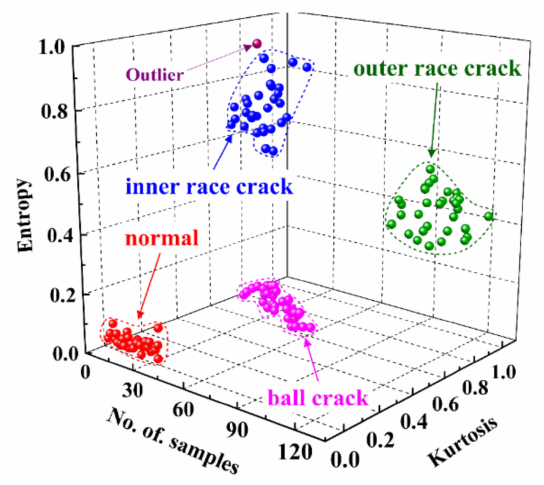
Figure 9. IMS bearing state feature clustering effect